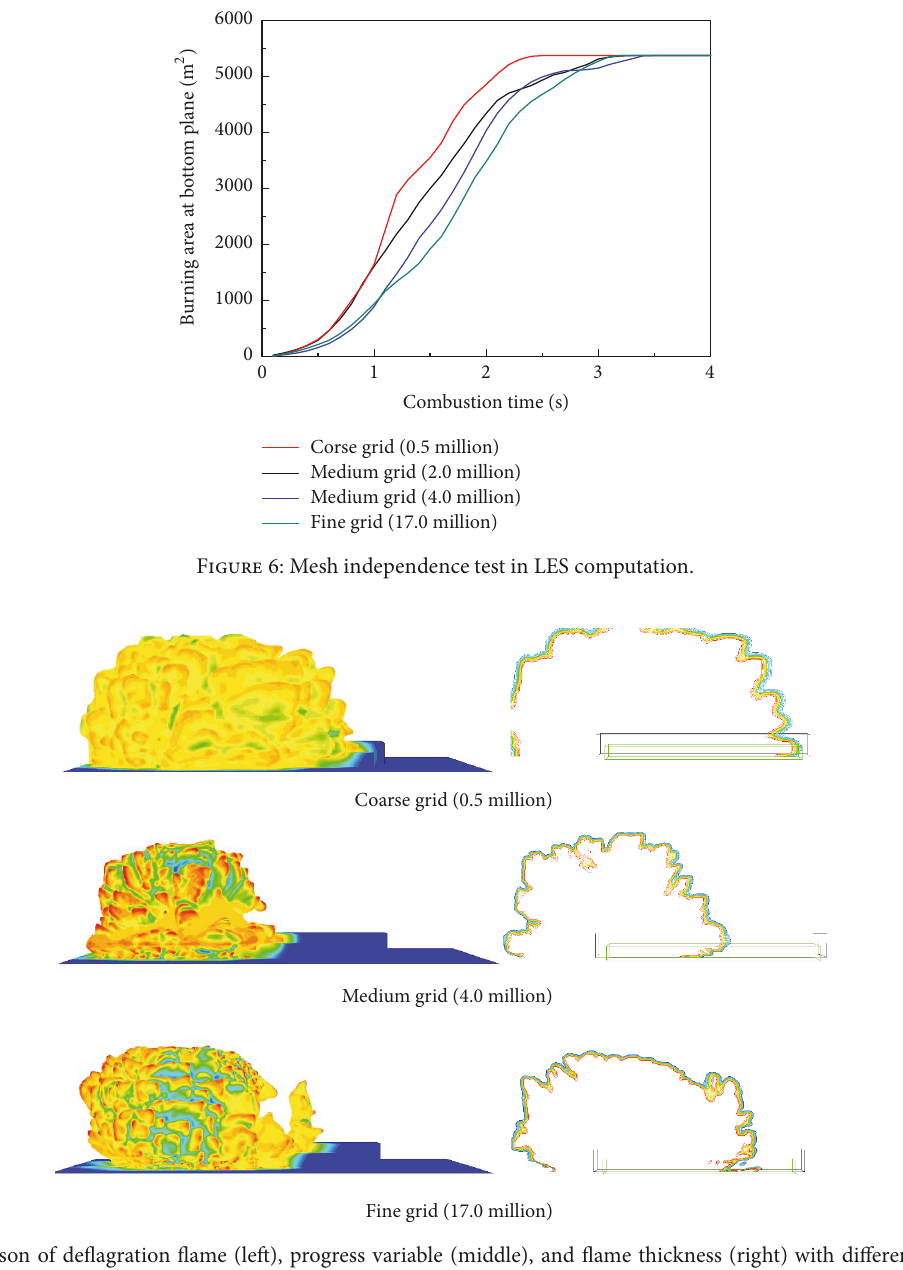
Figure 7: Comparison of deflagration flame (left), progress variable (middle), and flame thickness (right) with different grid resolutions (combustion time